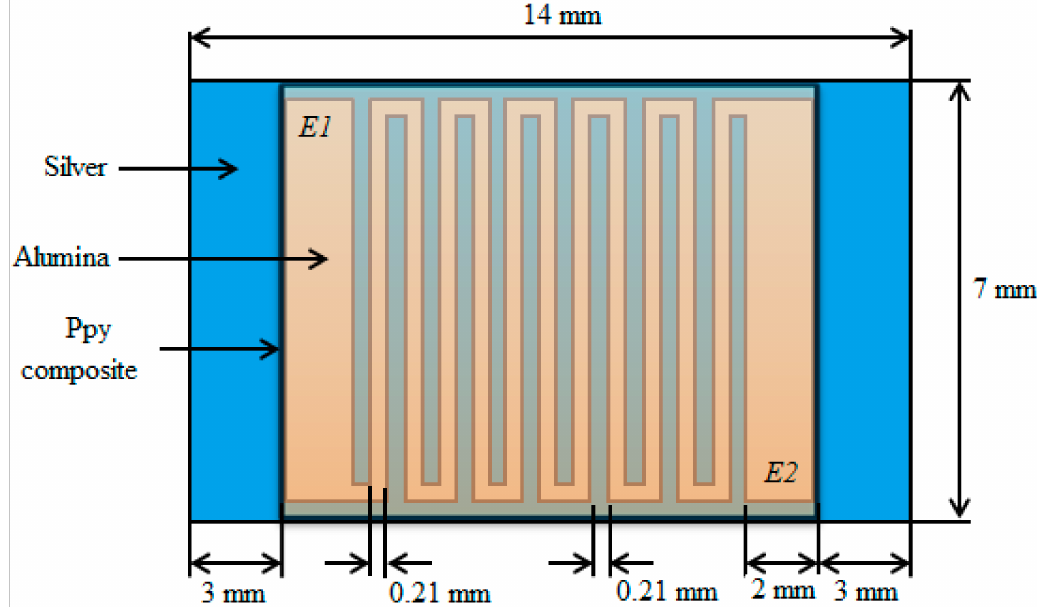
Figure 6. Actual schematic configuration of interdigitated electrodes in the newly fabricated thin film sensor for measuring humidity (top